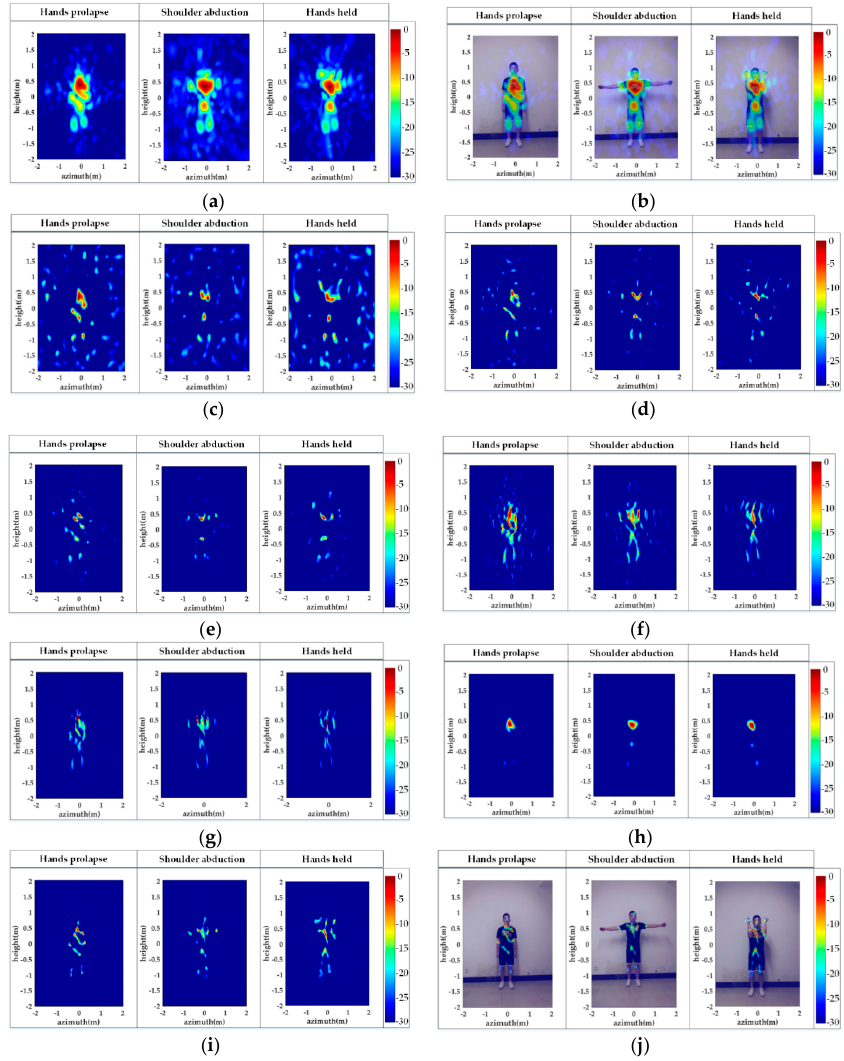
Figure 5. ( a ) BP imaging result; ( b ) Registration figure for BP imaging; ( c ) Enhanced imaging result with Wiener filtering; ( d ) Enhanced imaging result with Tikhonov regularization; ( e ) Enhanced imaging result with Tikhonov-Miller (TM) regularization; ( f ) Enhanced imaging result with LR algorithm; ( g ) Enhanced imaging result with LRMER algorithm; ( h ) Coherence Factor (CF) weighted method; Enhanced imaging result with LRTV algorithm; ( i ) Enhanced imaging result with LRTV algorithm; ( j ) Registration figure for LRTV algorithm.